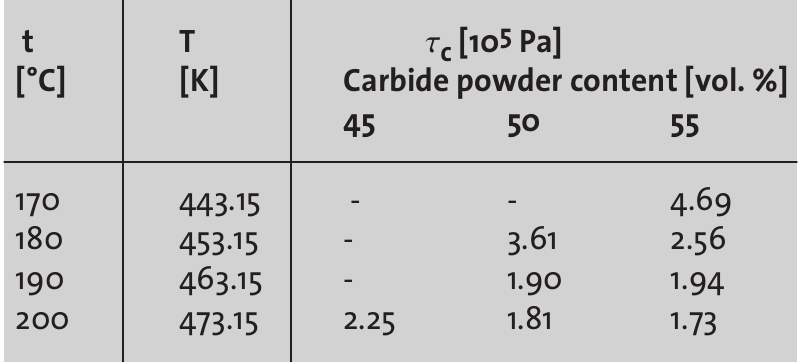
Table 2: Temperature dependence of critical apparent shear stress at the onset of pressure